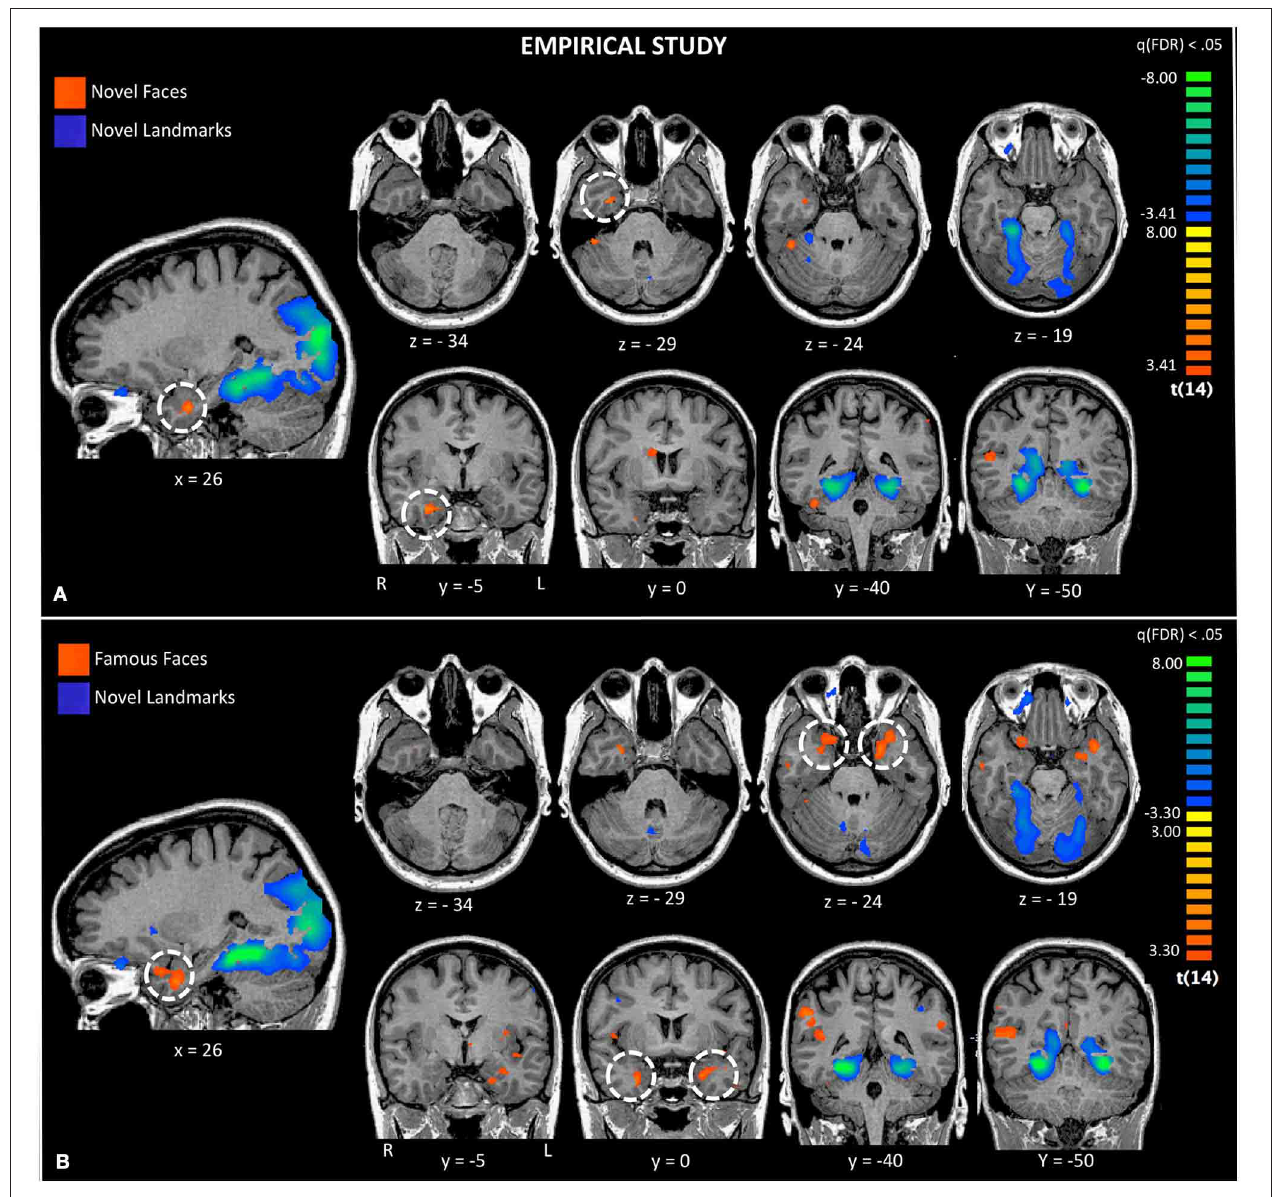
FIGURE 3 | Activations to a comparison of novel faces and novel landmarks from the empirical study are also shown (Panel A). The white circle highlights activation to novel faces in the right ATL. Activations to a